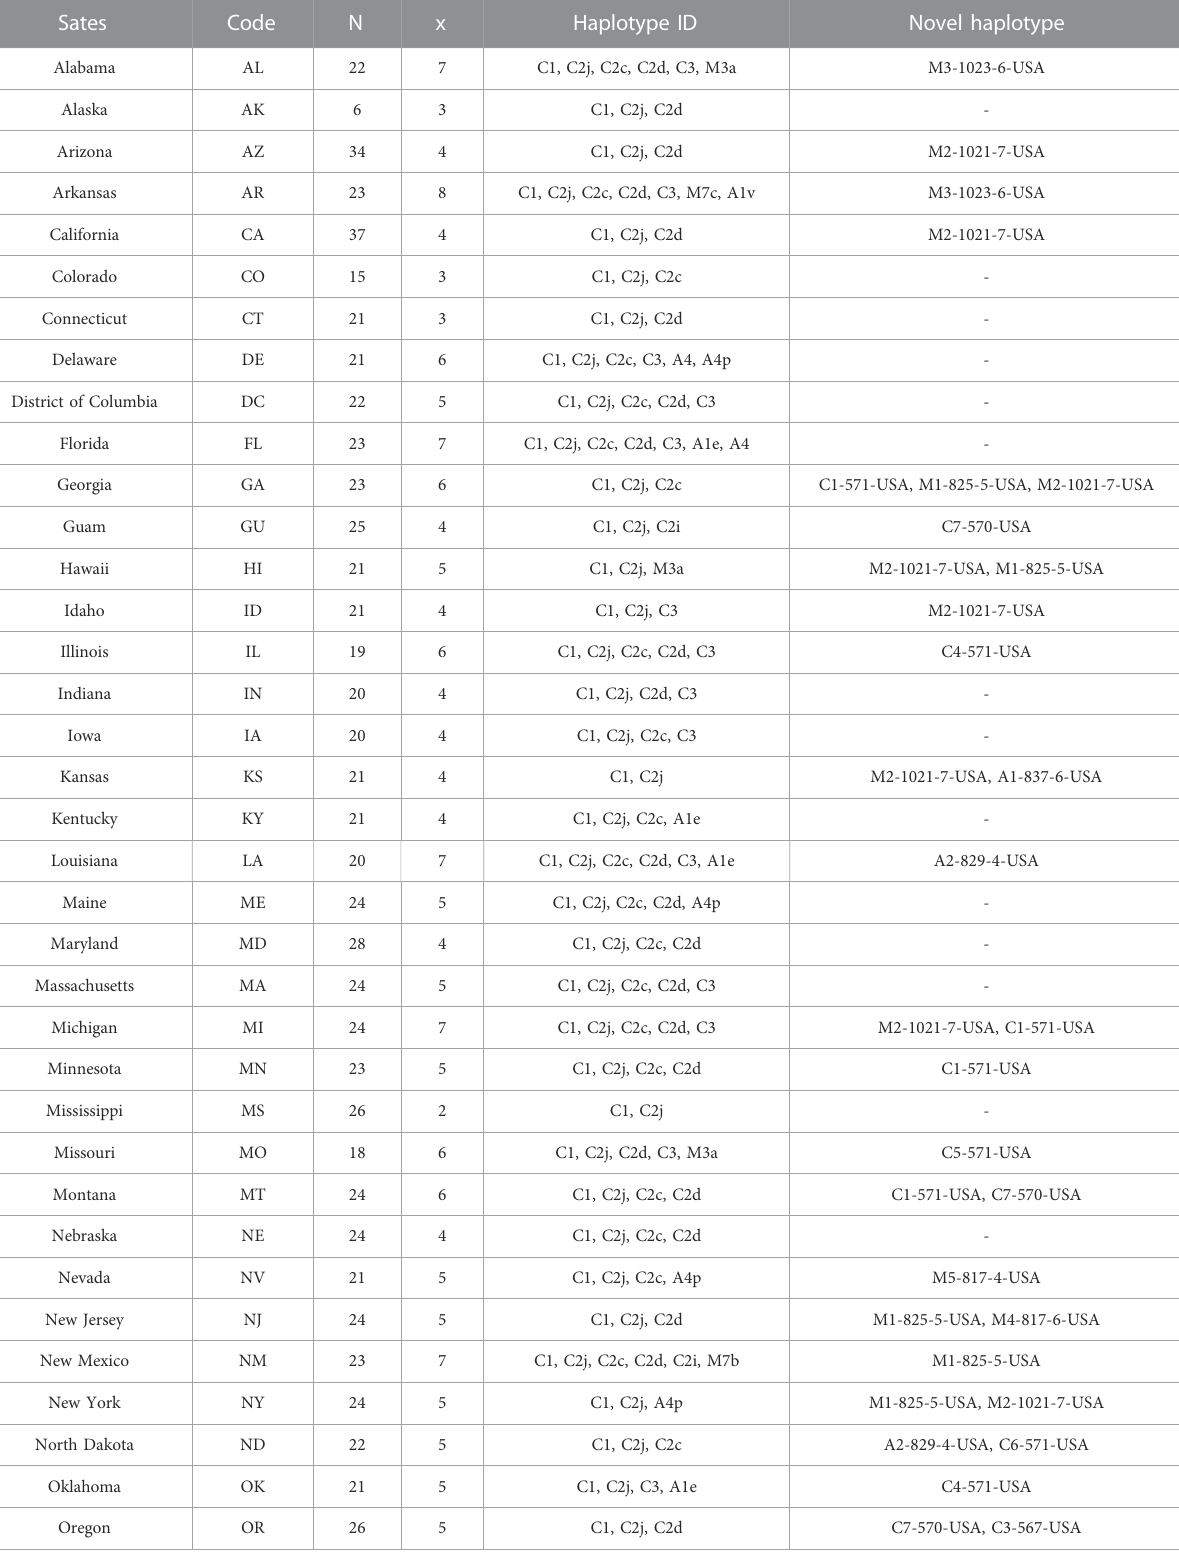
TABLE 2 Haplotype identity and occurrence on a state-by-state basis. Sample size (n), total number of haplotypes found in each population (x). Novel haplotypes found in the USA were named according to the nomenclature detailed in this study.